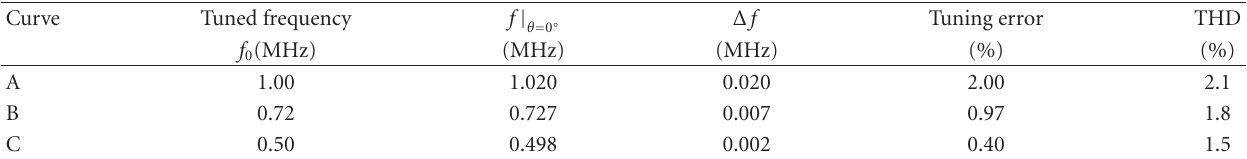
Table 2: Tuning error and THD measured at three di ff erent tuning frequencies.